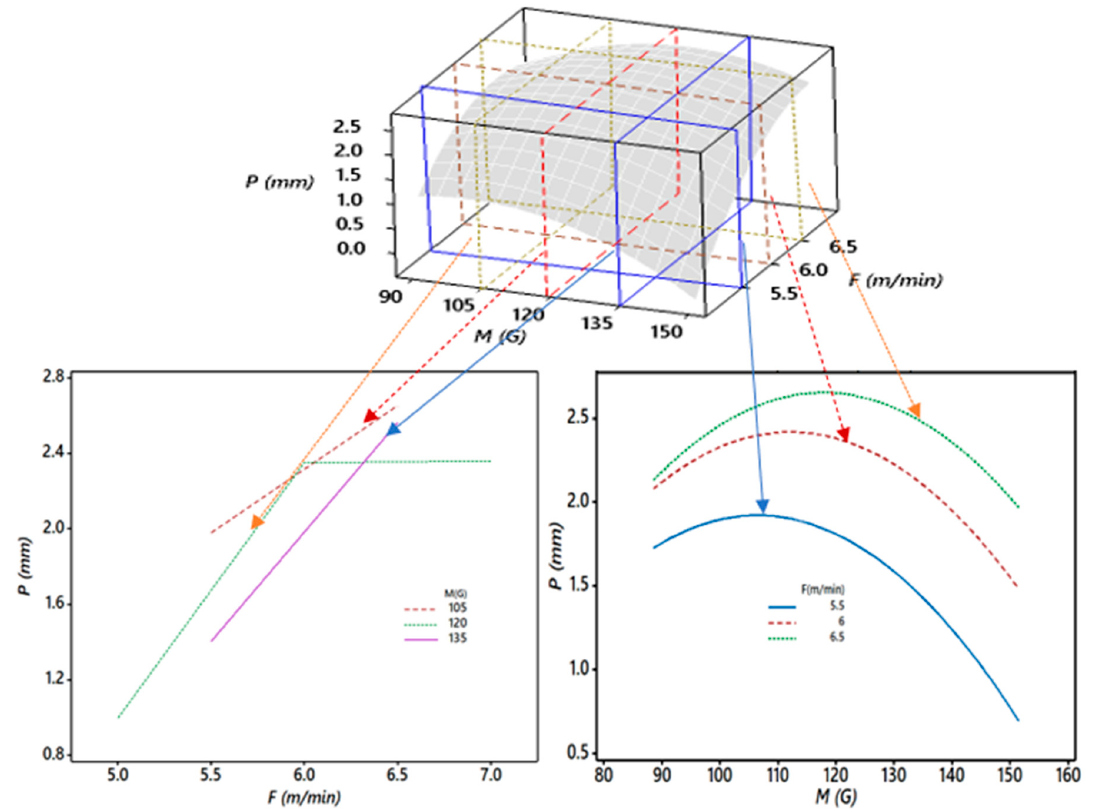
Figure 11. Sectioned 3D and 2D plots for the interaction e ff ects of M and F on P .